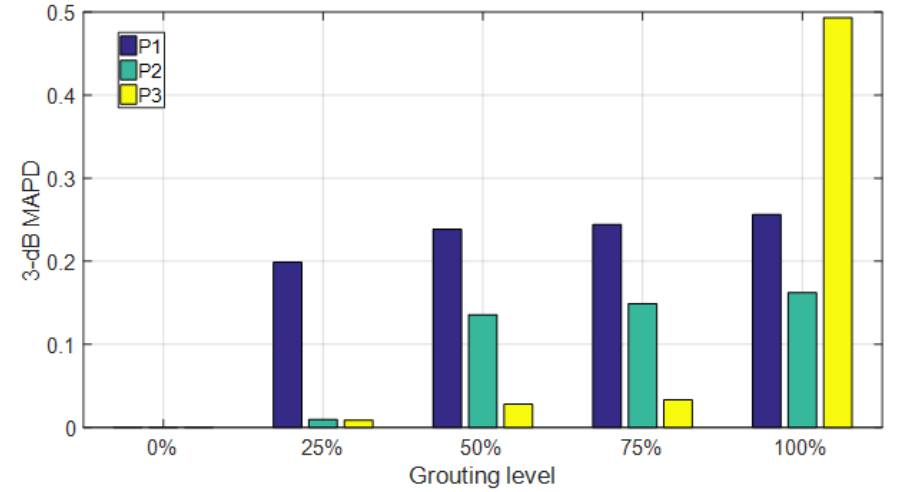
Figure 9. 3-dB mean absolute percentage deviation (MAPD) for different grouting compactness levels.